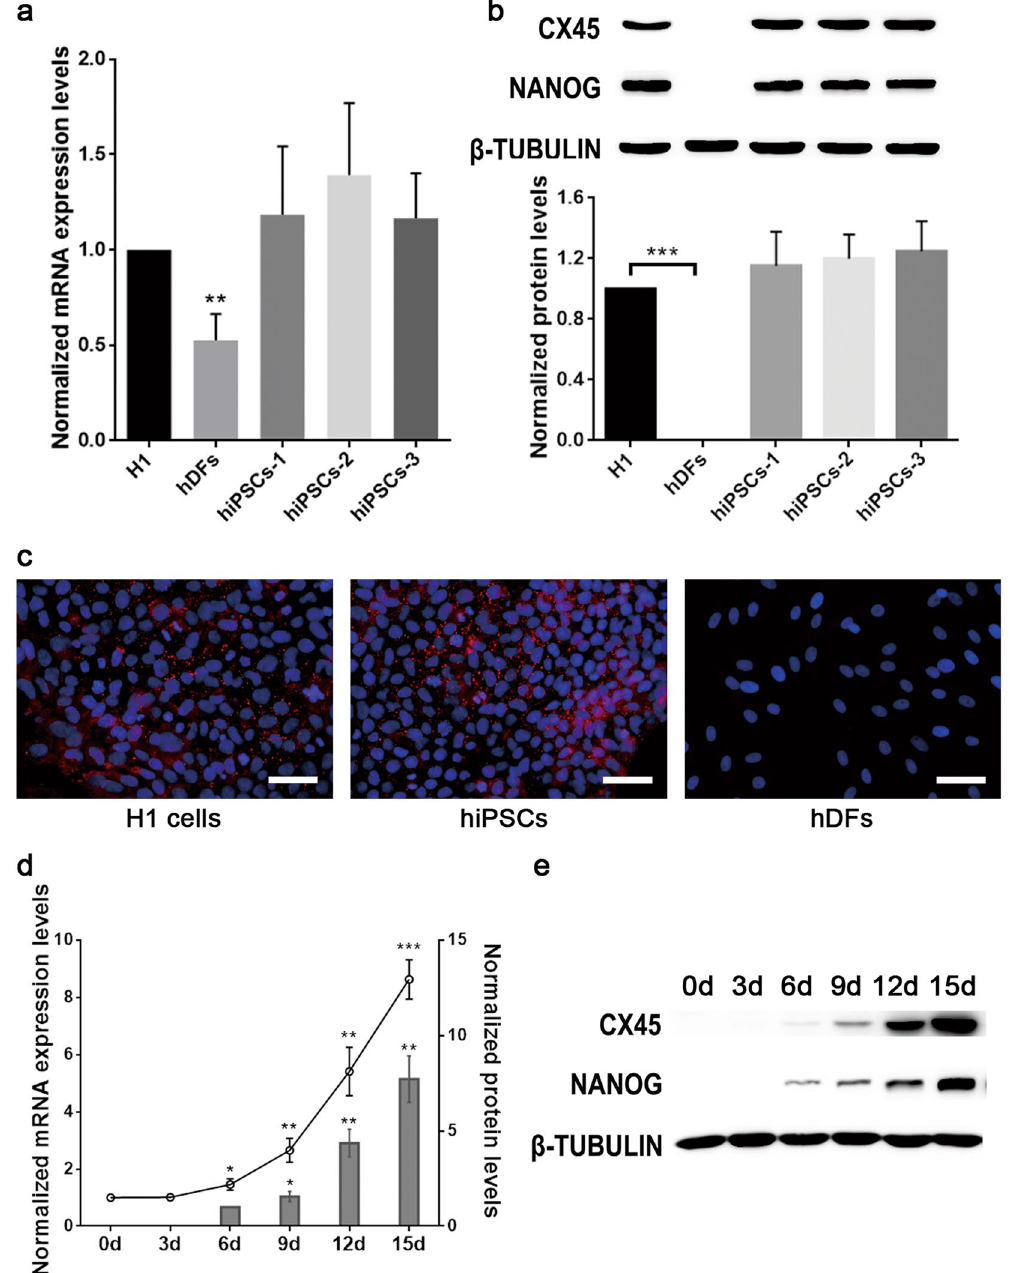
Figure 2. CX45 expression increased in OSKM transduced hDFs during the reprogramming process. ( a ) CX45 expression in H1 cells, hDFs and hiPSCs was assessed by real-time PCR; CX45 expression in the H1 cells was arbitrarily assigned a value of 1.0. ( b ) CX45 protein level in H1 cells, hDFs and hiPSCs was assessed by western blotting analysis; CX45 protein level in the H1 cells was arbitrarily assigned a value of 1.0. The data are presented as the mean ± S.E.M. (n = 3) and are representative of three independent experiments. ** P < 0.01, *** P < 0.001 versus H1 cells. ( c ) Immunofluorescence analysis of CX45 in H1 cells, hiPSCs and hDFs; the nuclei were visualised with DAPI staining (blue). Scale bar = 50 μ m. ( d ) CX45 expression on the indicated days in OSKM transduced hDFs during the reprogramming process was assessed by real-time PCR (dot plot) and western blotting (column graph); CX45 mRNA expression on day 0 was arbitrarily assigned a value of 1.0. CX45 protein levels on day 6 was arbitrarily assigned a value of 1.0. The data are presented as the mean ± S.E.M. (n = 3) and are representative of three independent experiments. * P < 0.05, ** P < 0.01, *** P < 0.001 versus the one assigned a value of 1.0. ( e ) CX45 and NANOG expression on the indicated days in OSKM transduced hDFs during the reprogramming process was assessed by western blotting